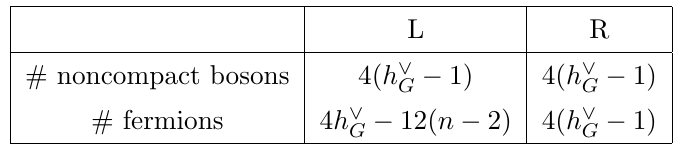
Table 16. Degrees of freedom of the h G